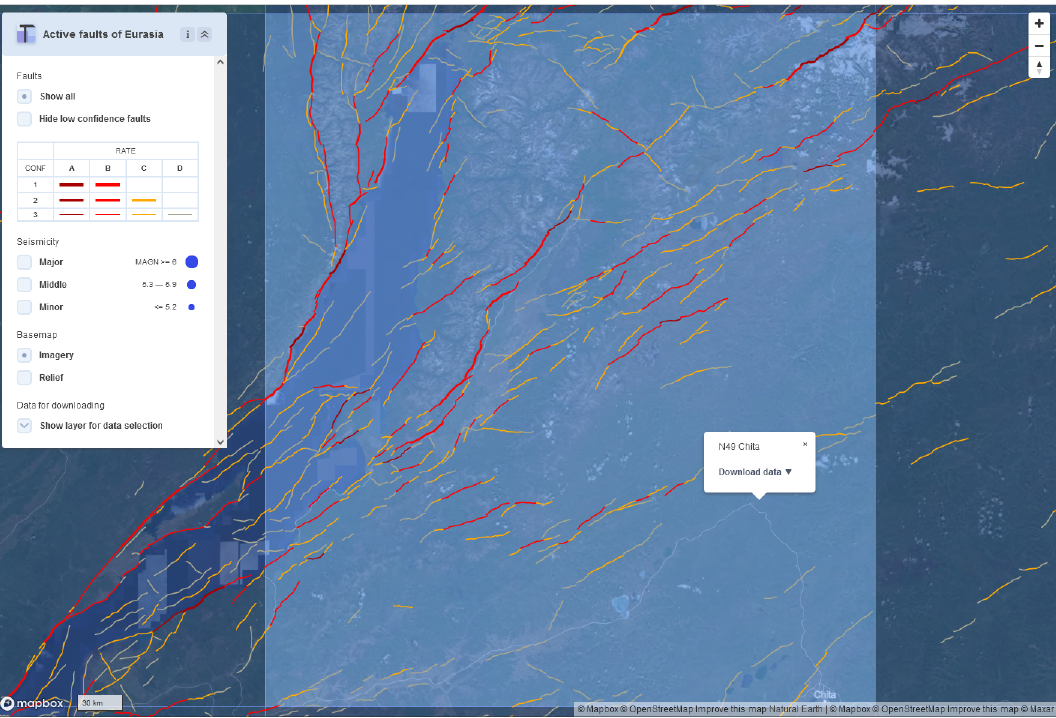
Figure 11. Representation of active faults at the Baikal rift zone by the AFEAD web interface (http://neotec.ginras.ru/index/mapbox/ database_map.html, last access: 5 May